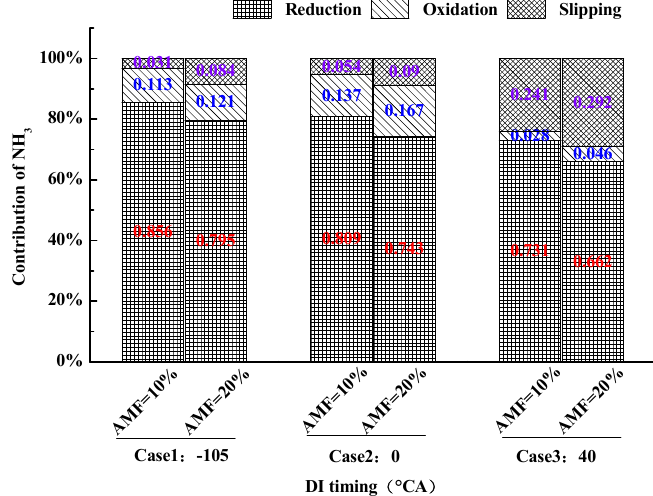
Figure 15. Contribution of ammonia.